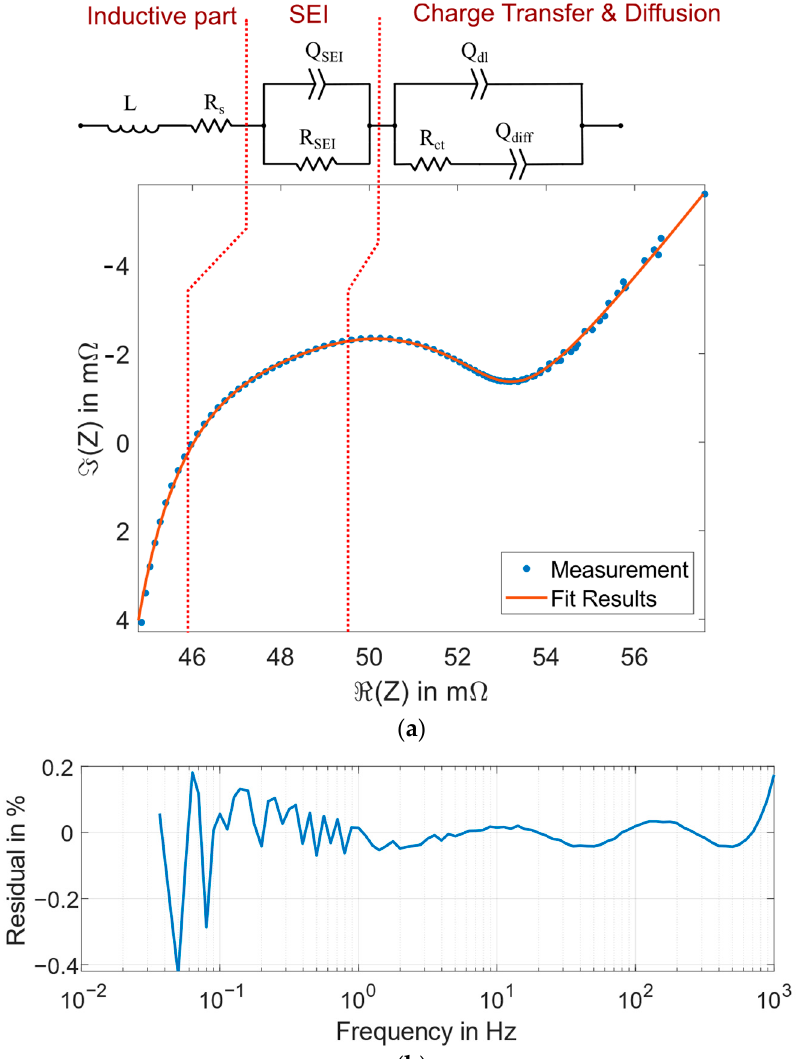
Figure 8. ( a ): Fitting result of the ECM model to the impedance spectrum of cell one, cycle 150 and ( b ): The residual of the fitted ECM model to impedance spectrum of cell one, cycle 150.